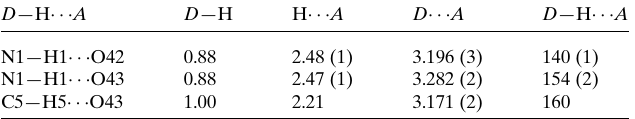
Table 2 Hydrogen-bond geometry (A˚ , (cid:4) ).